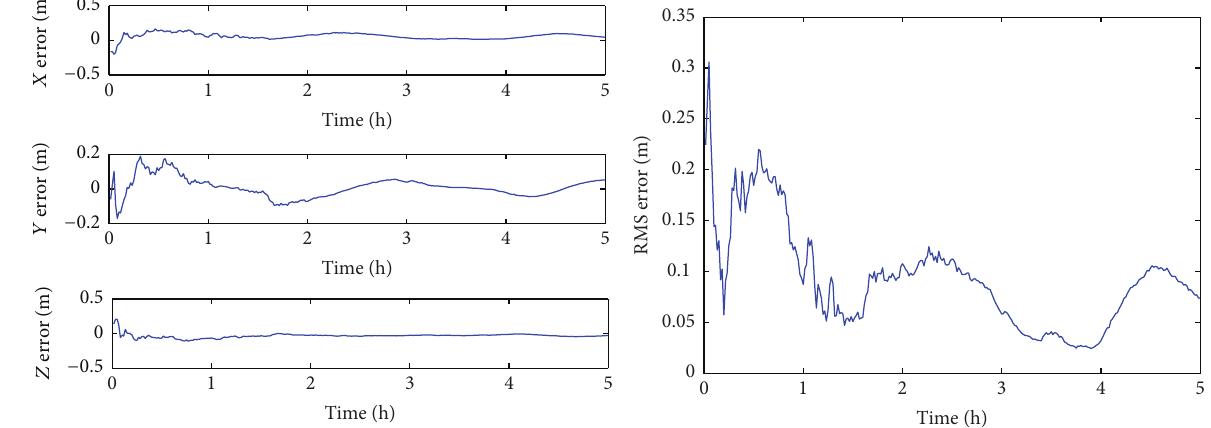
Figure 8: Error of absolute position estimation of satellite 3 using FOEKF.